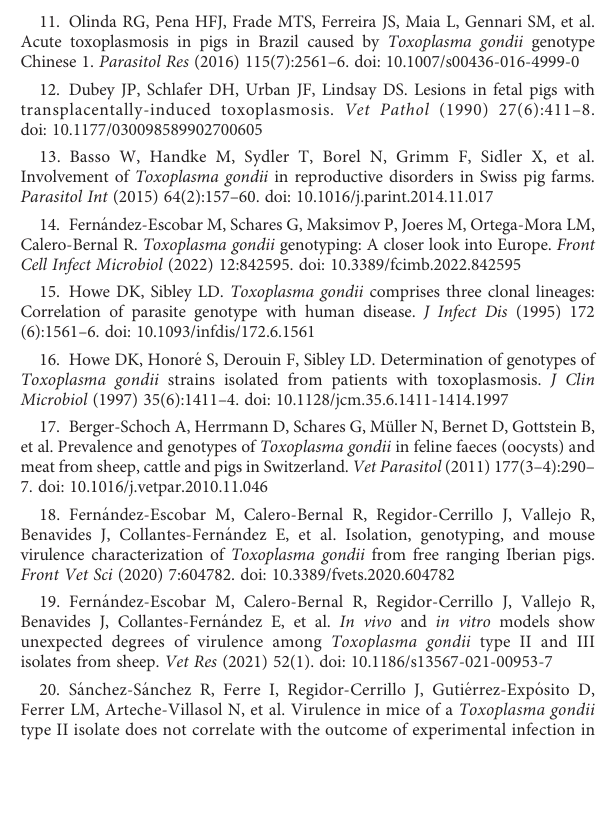
gondii stimulation at 14 and 21 days post-infection (dpi): IL-8 (A, B) , IL-12 (C, D) and IL-1 b (E, F) . Box-plot graphs representing median and 25 th to 75 th percentiles of cytokine levels of the individual values from groups infected with TgShSp1 (G1), TgShSp24 (G2) and non-infected (G3). Whiskers represent the largest and smallest values Signi fi cant differences between groups are indicated with asterisks, where * and